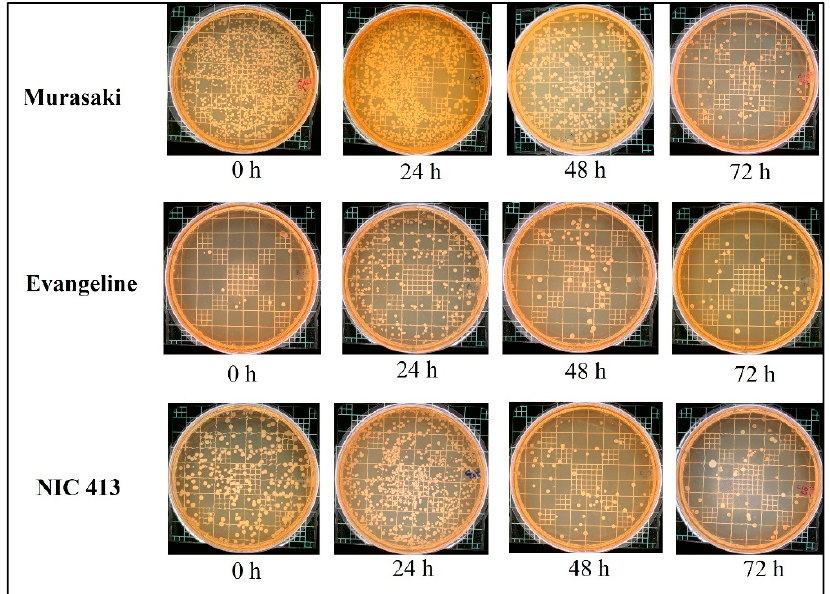
Figure 2. Viable cell count of Lactiplantibacillus plantarum (at 10 − 3 dilution) in LAB fermented sweet potato cultivars; Murasaki, Evangeline, and NIC-413 at 0, 24, 48, 72 h incubation (37 °C).